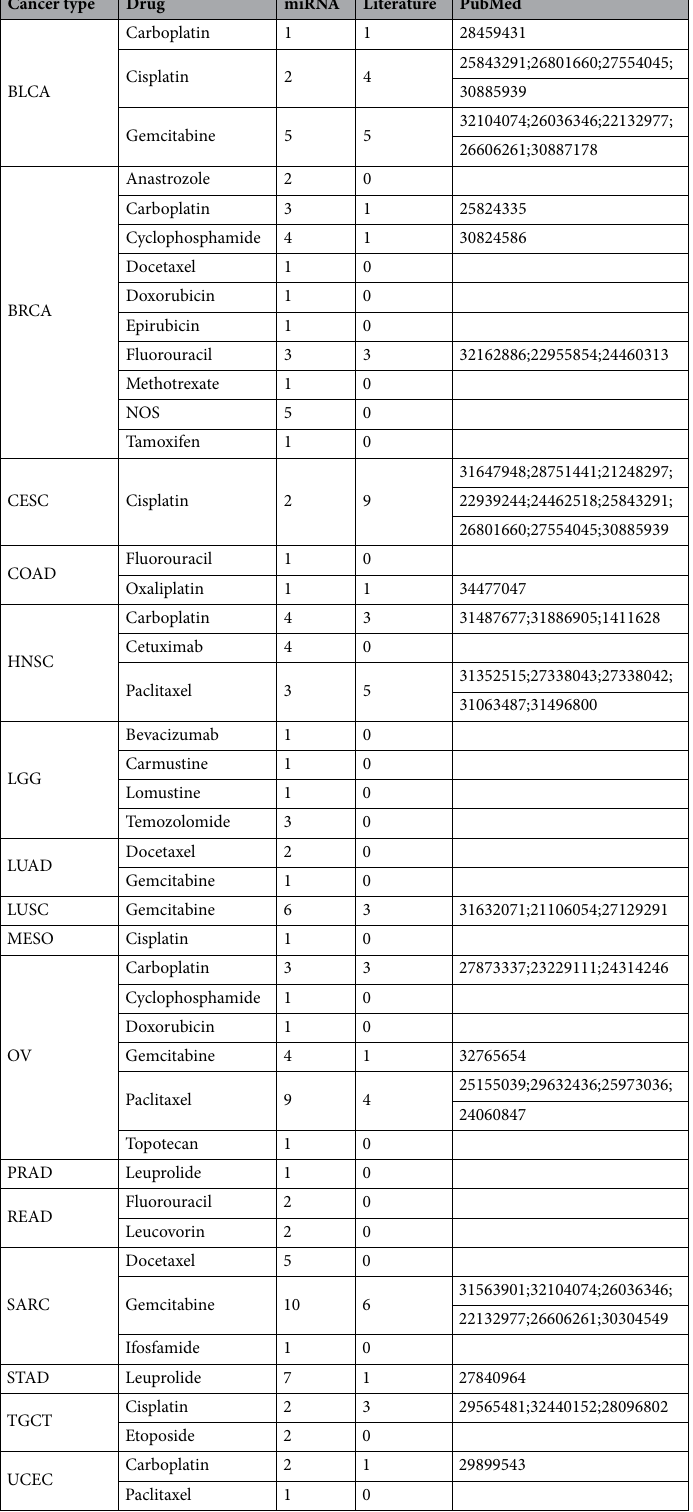
Table 1. Significant miRNAs identified in cancer-drug groups. This table represents the number of significant miRNAs identified in all cancer-drug groups. The Literature column represents the number of literature found by PubMed search for each